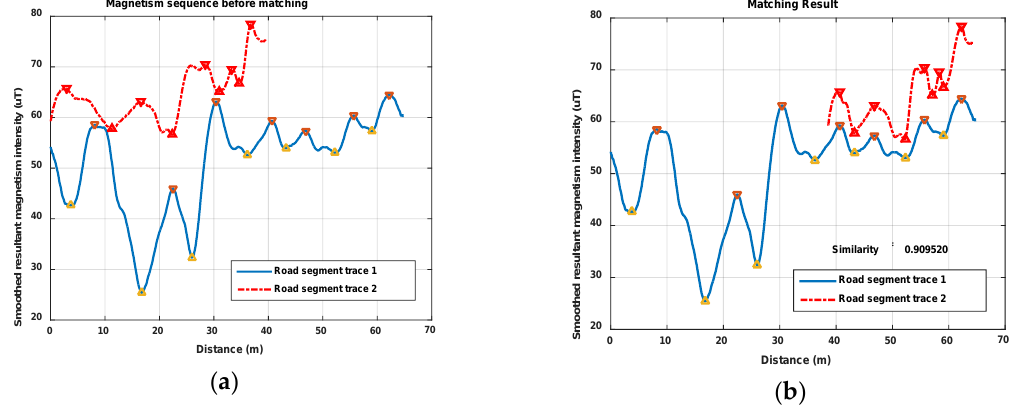
Figure 13. Magnetism matching and similarity calculation results when trace 2 is partly generated on the same road segment that trace 1 was generated on: ( a ) smoothed magnetism sequences and detected features marked by the initial estimated distance; ( b ) magnetism sequences after feature matching and sequence zooming, and the calculated similarity between